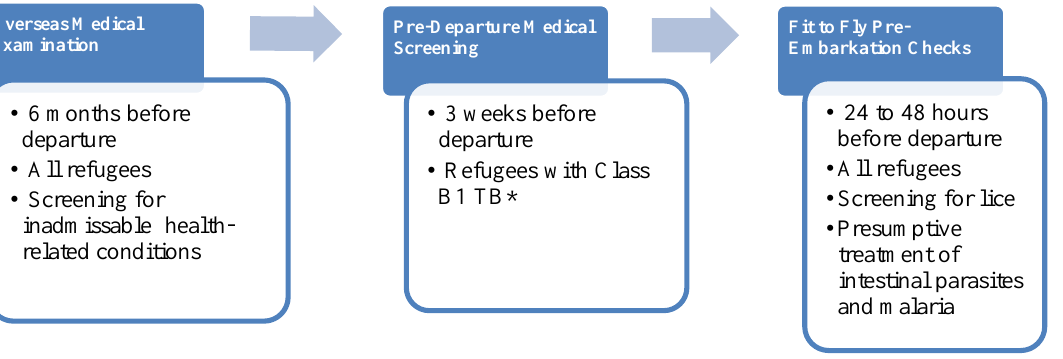
* Class B1 TB refers to TB fully treated by directly observed therapy, or abnormal chest x-ray with negative sputum smears and cultures, or extrapulmonary